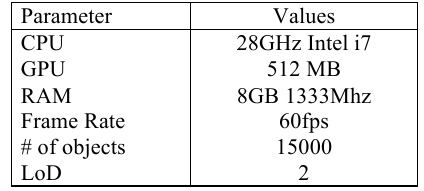
Table 1 Performance of the rendering in functions of Hardware characteristics